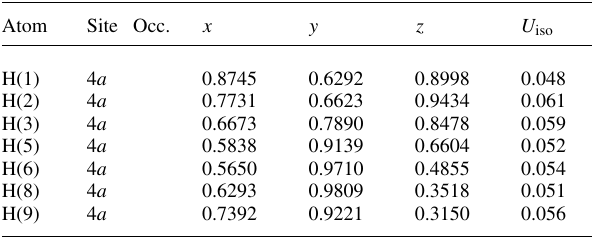
Table 2. Atomic coordinates and displacement parameters (in Å 2 )